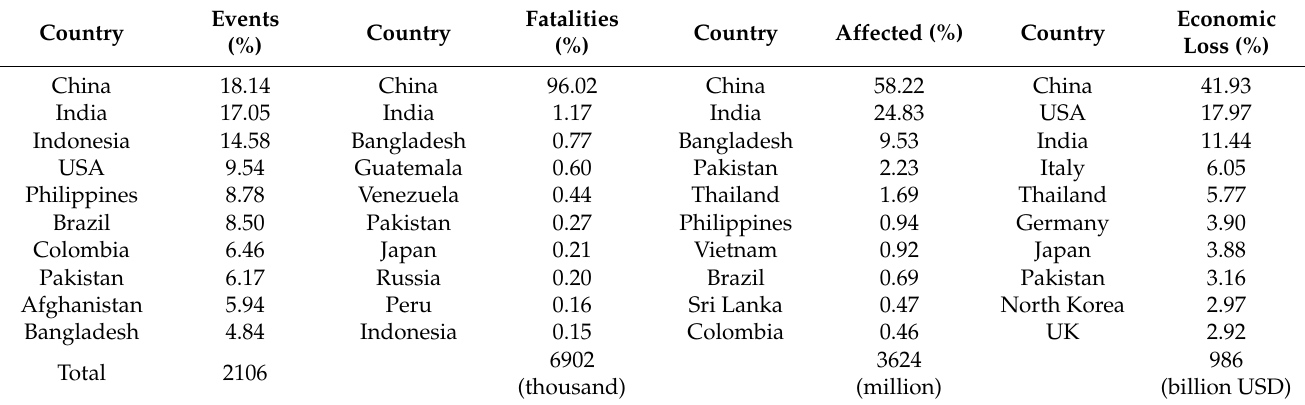
from 1900 to 2020 AD (Data Source: